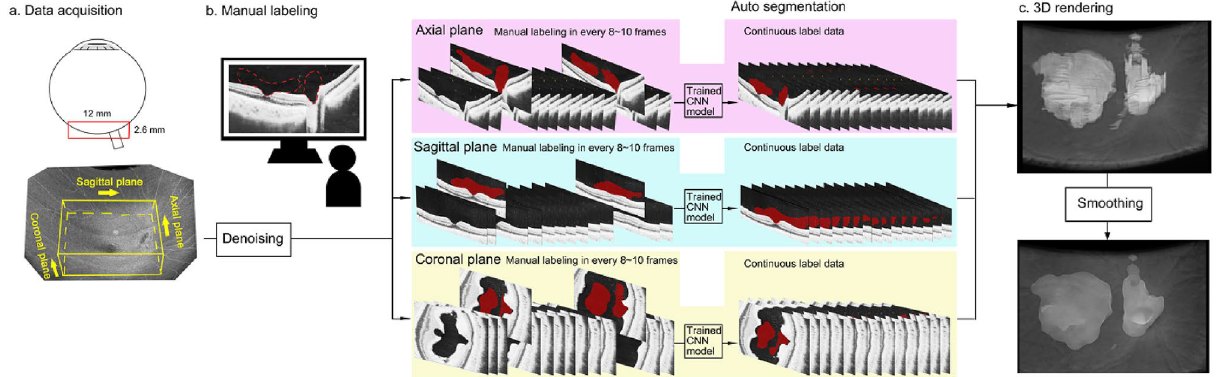
Figure 1. Machine learning-based detection and segmentation of vitreous fluidic cavities for 3D modeling of the posterior vitreous. ( a) Optical coherence tomographic (OCT) volume scan data are acquired at the midpoint between the fovea and optic disc. The scanned area is set to 12 × 9 × 2.6 mm 3 and orthogonal 3 planes of 2D OCT images are defined as axial, sagittal, and coronal plane. The OCT data are preprocessed with a deep learning (DL)-based noise reduction algorithm. ( b) The vitreous fluid area was manually labelled in representative 2D OCT images for every 8–10 frames, along the axial, sagittal, and coronal planes. A deep convolutional neural network (DCNN) was trained to segment the vitreous fluid area based on the manual labels in each plane.